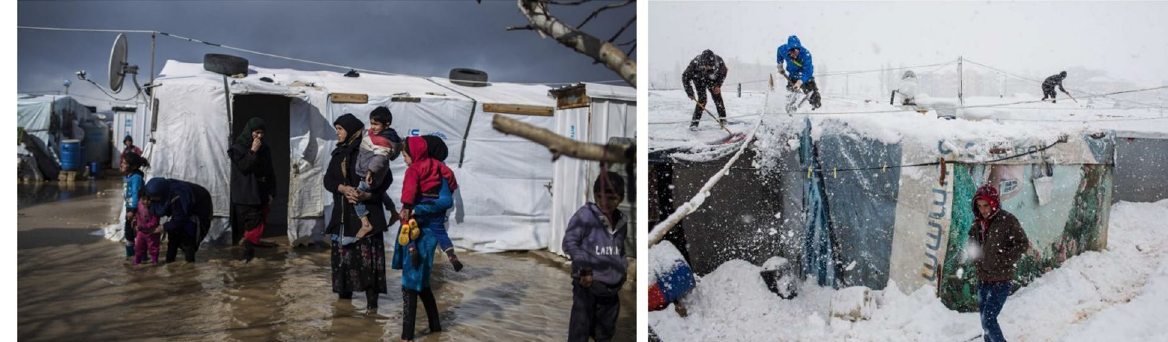
Fig. 3 (left) Syrian refugees walking through the flooded streets of Dalhamiye informal settlement in Bekaa Valley, Lebanon, January 2019. © UNHCR/Diego Ibarra Sánchez ; (right) Syrian refugees removing snow from their shelters at an informal tented settlement in the Bekaa Valley, Lebanon during a blizzard, January 2015. (UNHCR/A.McConnell) (Source: Refugees caught in heavy snow as storms lash Lebanon and Jordan. https:// www. unhcr. org/ news/ latest/ 2015/1/ 54ad5 ee49/ refug ees- caught- heavy- snow- storms- lash- leban on- jordan. html Ariane Rummery UNHCR